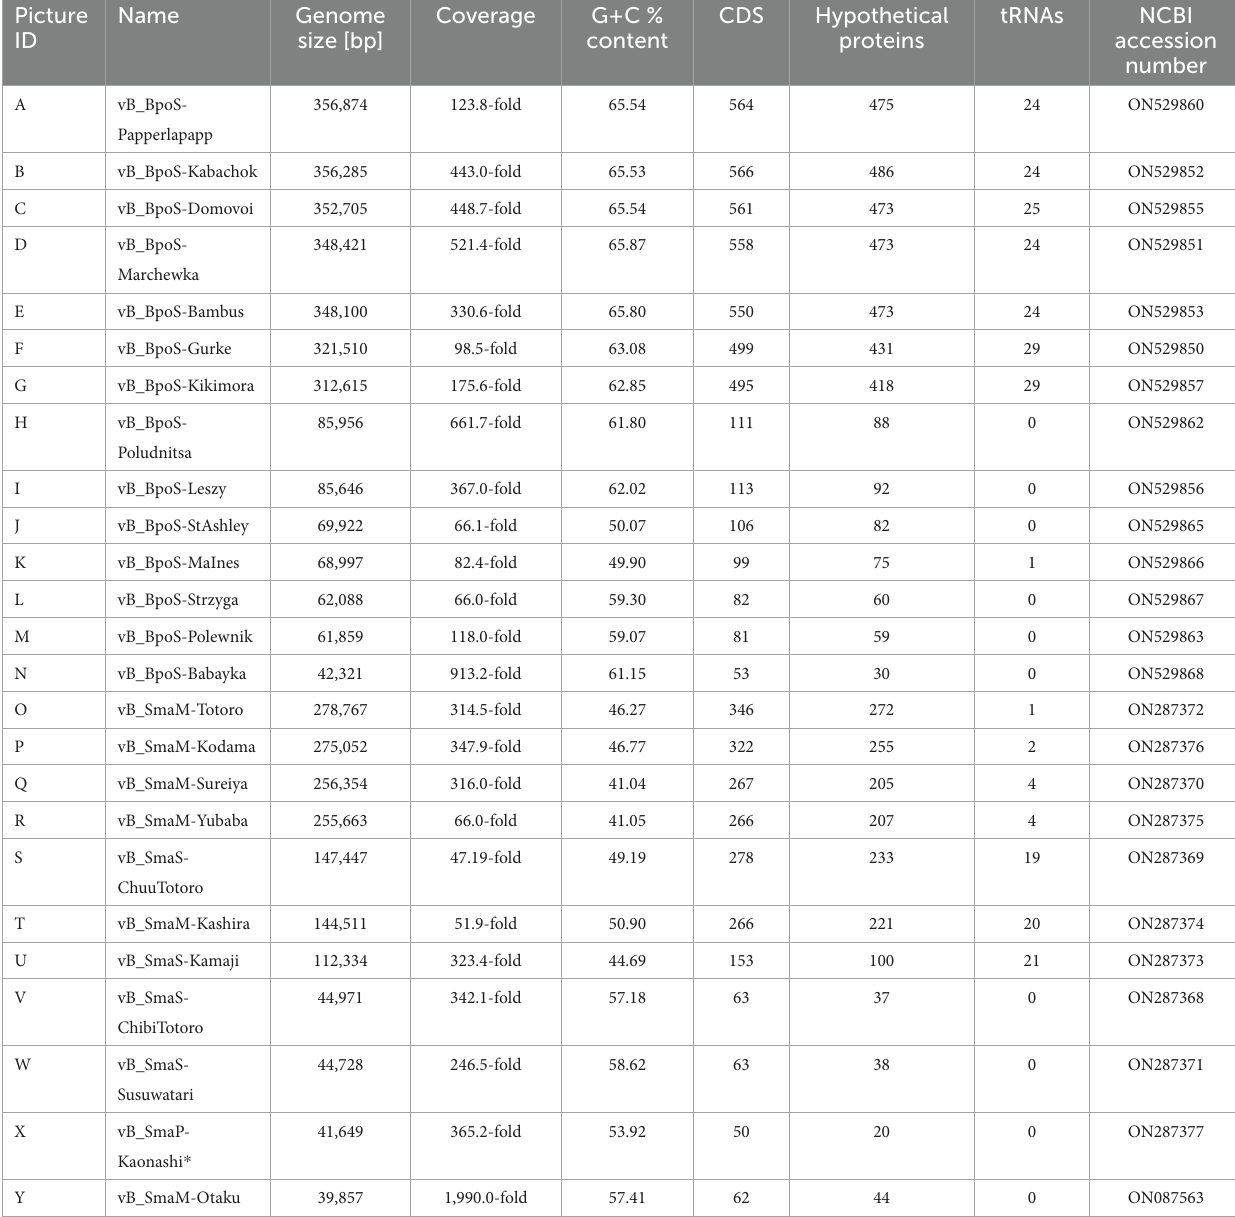
TABLE 2 Genome analyses of all phage isolates associated with B. pondensis and S. marcescens